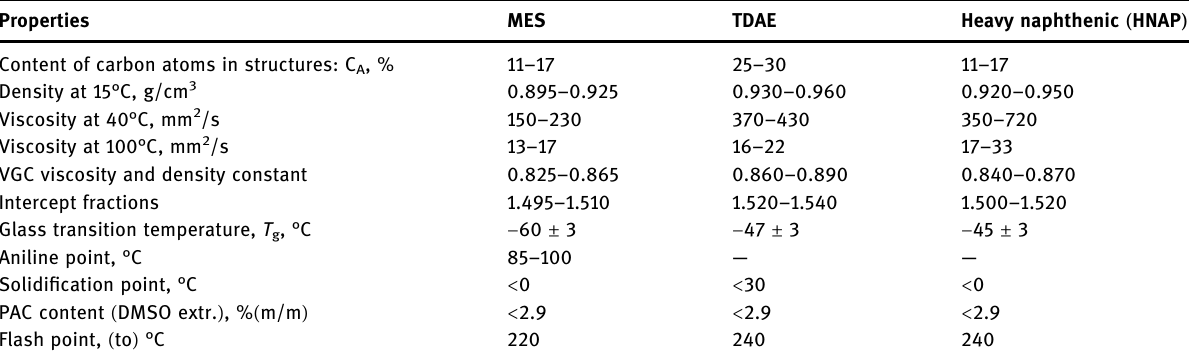
Table 1: Physiochemical properties of petroleum plasticisers